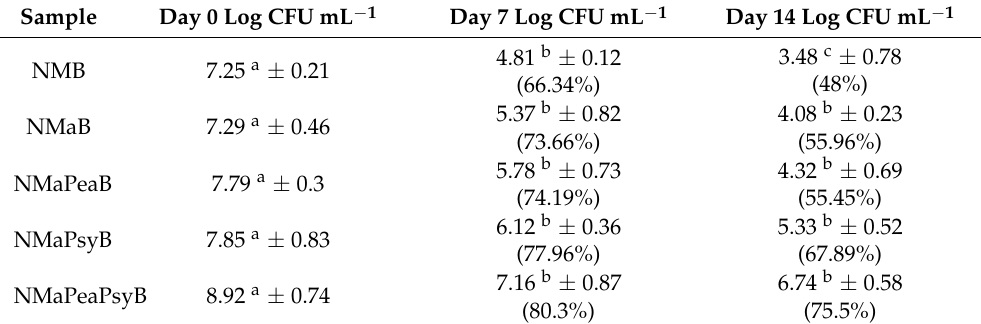
Table 2. Survival of the bacterial growth and survival percentage in Natal plum ( Carissa macrocarpa ) juices over a 14-day storage